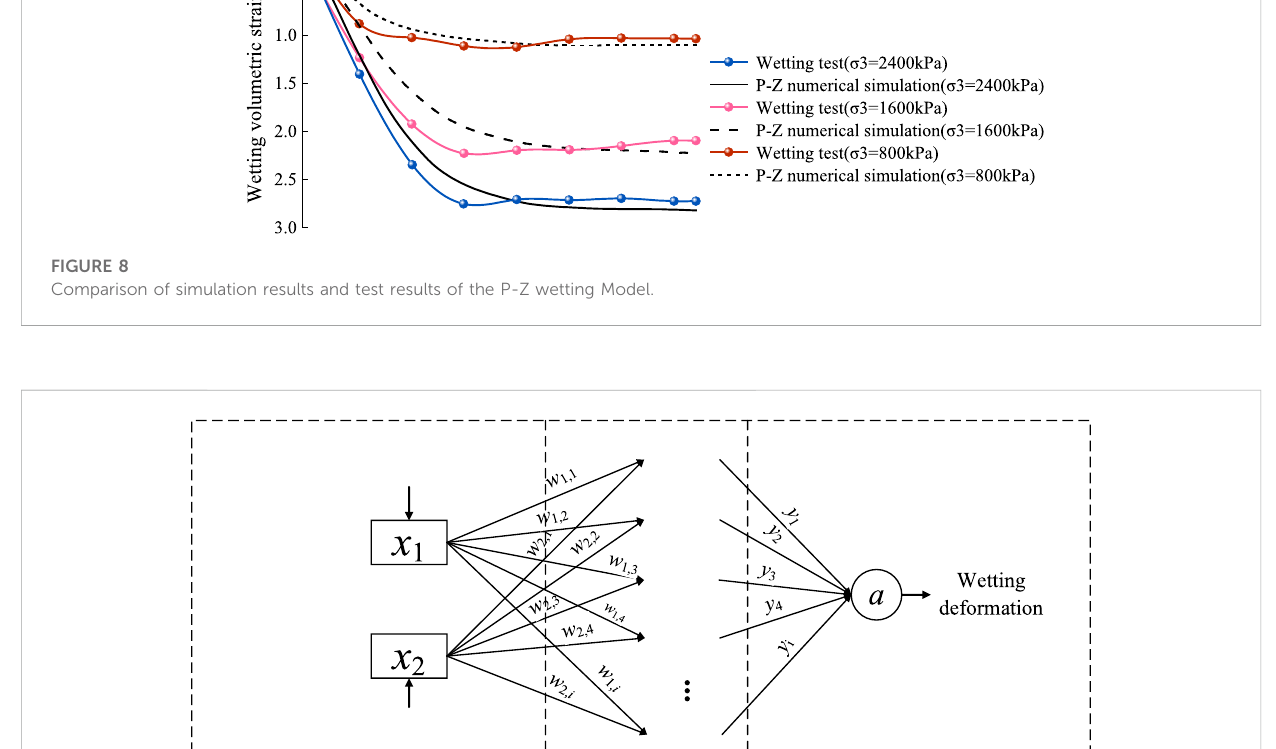
FIGURE 9 BP neural network